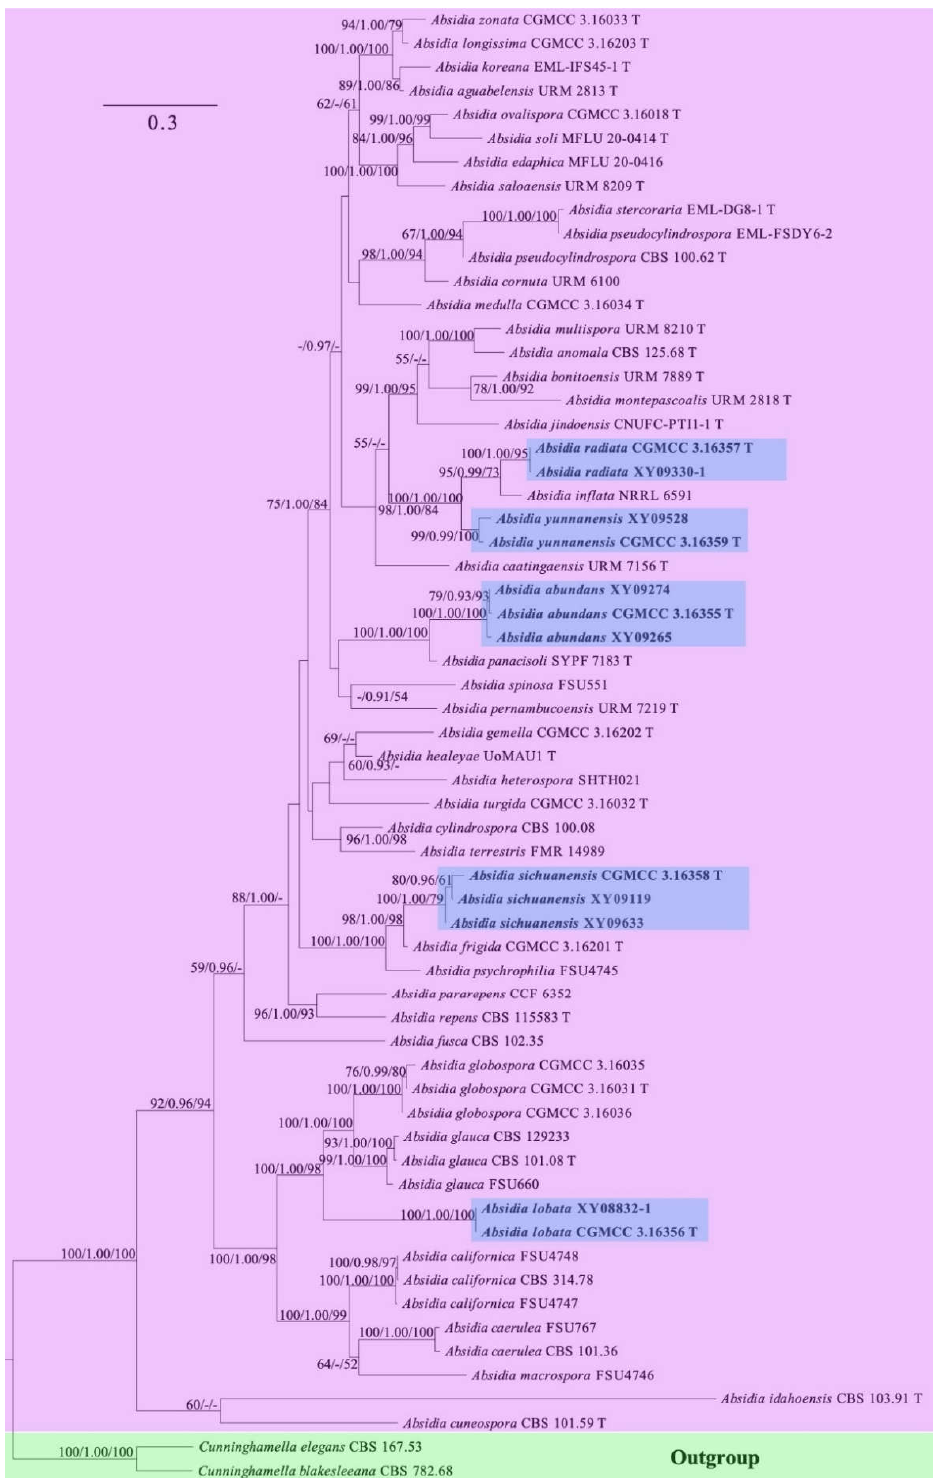
Figure 2. Maximum likelihood (ML) phylogenetic tree of Absidia based on ITS and LSU rDNA sequences, with Cunninghamella elegans and C. blakesleeana as outgroup shaded in blue. Five new species are in shade and bold. Maximum likelihood bootstrap values (≥50%)/Bayesian inference (BI) posterior probabilities (≥0.9)/maximum parsimony (MP) bootstrap values (≥50%) of each clade are indicated along branches. “T” after strain number represents type. A scale bar in the upper left indicates substitutions per site.